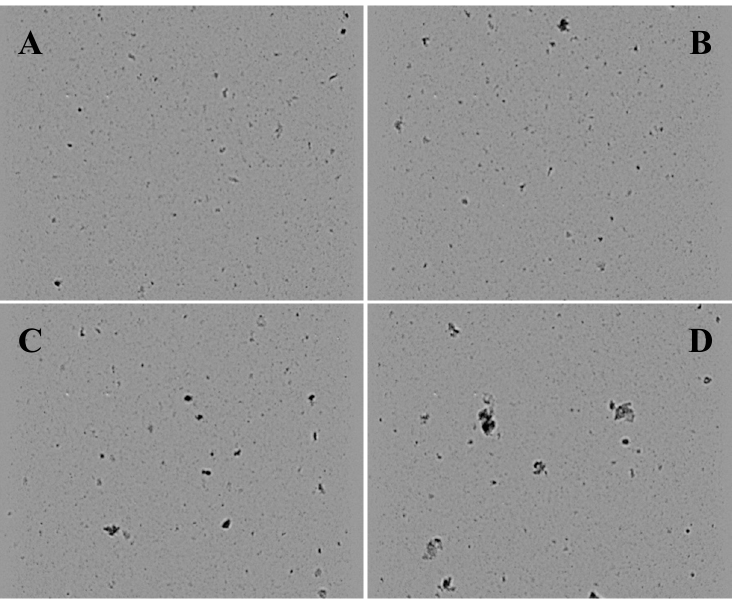
Figure 2. Images taken by the Flow-Cell: ( A ) G-1 solution; ( B ) G-2 solution; ( C ) G-3 solution; ( D ) G-4 solution; scale bar 100 µm.